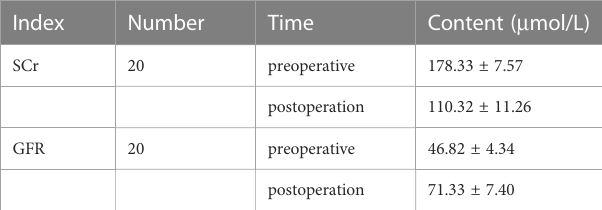
TABLE 4 The liver function evaluation of the patient.